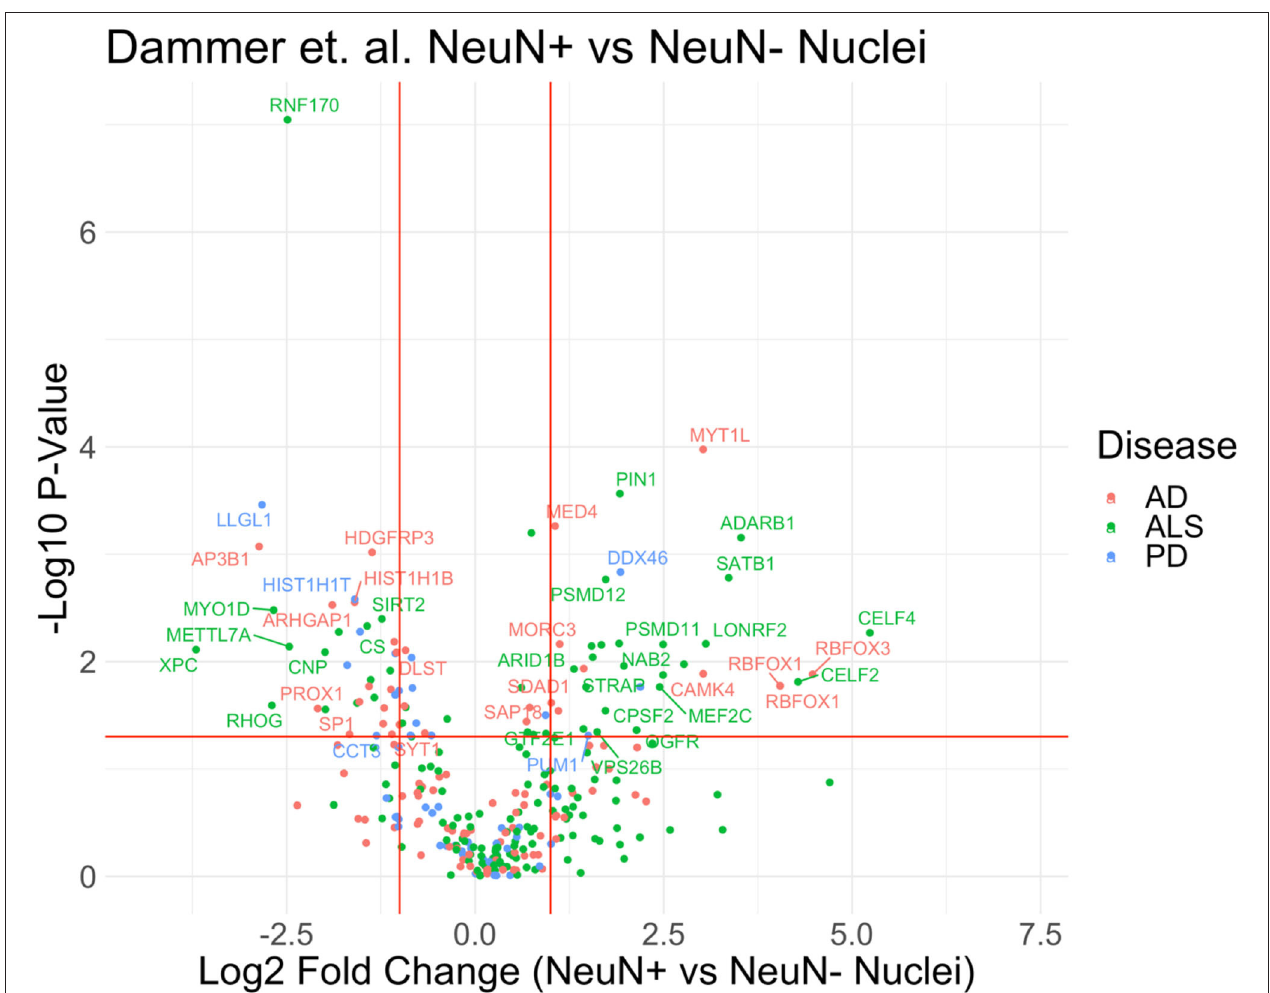
FIGURE 3 | Proteomics of neuronal and non-neuronal nuclei from frozen human post-mortem brain. Volcano plot of proteomic differences between NeuN + vs. non-NeuN Nuclei with highlighted disease markers that have p -value < 0.05 and fold change > 2. The reannotated data demonstrates that proteins found in cell-type specific nuclear populations are correlated to disease. List of MAGMA genes associated with each ND displayed in this figure can be found in Supplementary Table 1